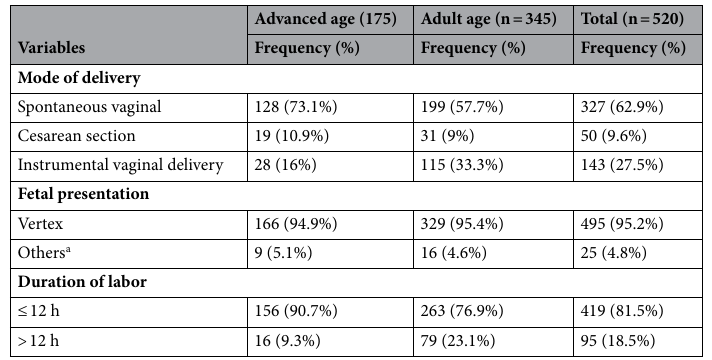
Table 2. Obstetrics characteristics of mothers who gave birth in Awi Zone Public Hospitals, Ethiopia, 12020. a Breech, shoulder and face.